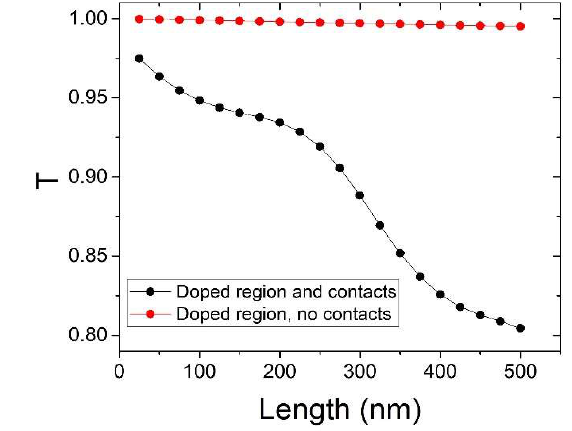
Fig. 3. Transmission coefficients from the input to the output port of the cavity as a function of the length of the doped area and therefore of the lateral